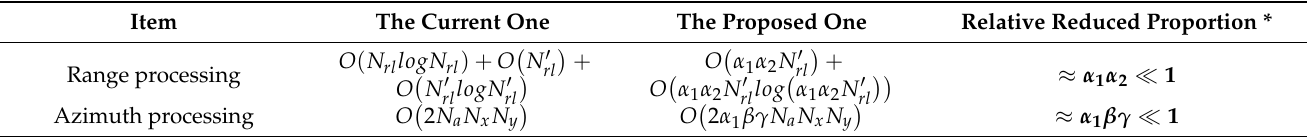
Table 2. Computation time consumption of the proposed processing module